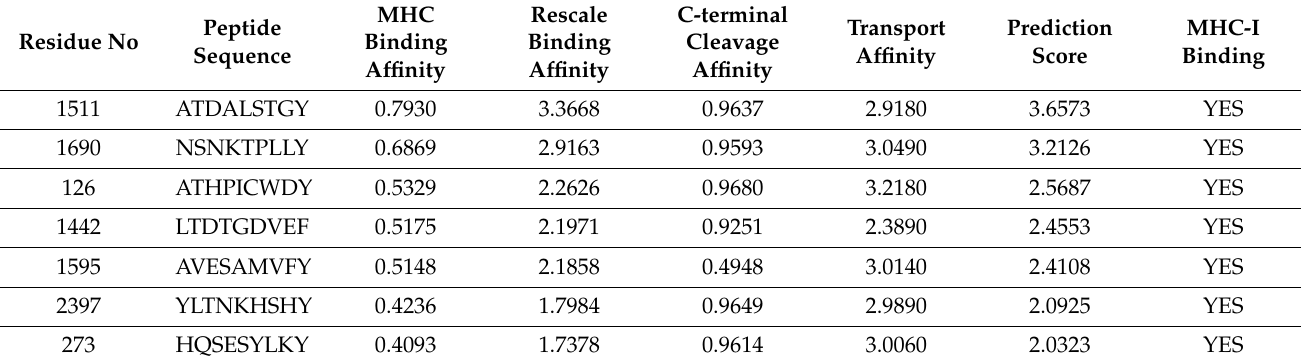
Table 1. List of final CTL epitopes selected on the basis of C-terminal cleavage, TAP score, and antigenicity.